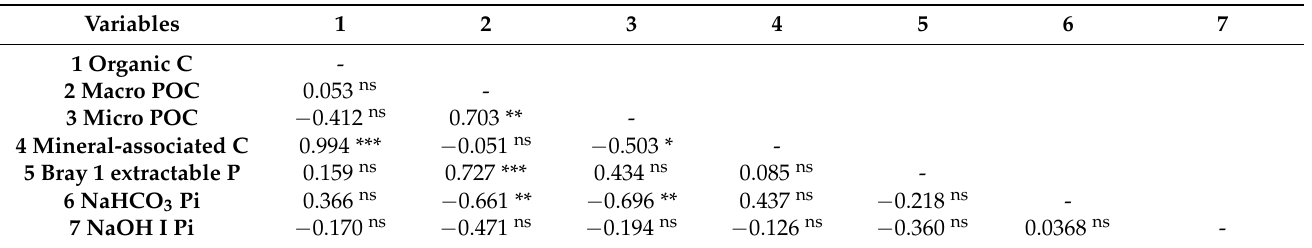
Table 6. Correlations of labile soil carbon and phosphorus fractions in the 0–50 mm soil